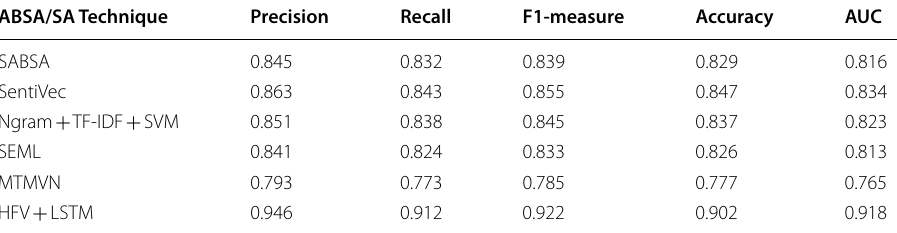
Table 3 Comparison of HFV Methods